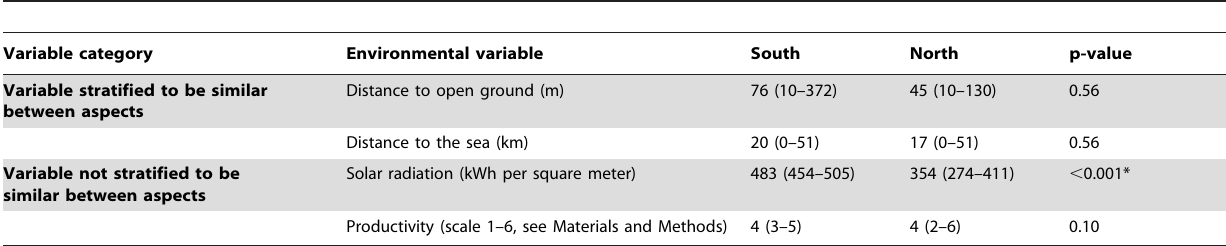
Table 1. Comparison between south- and north-facing slopes of the environmental variables used in the performance analyses (except for microclimatic variables, see Table